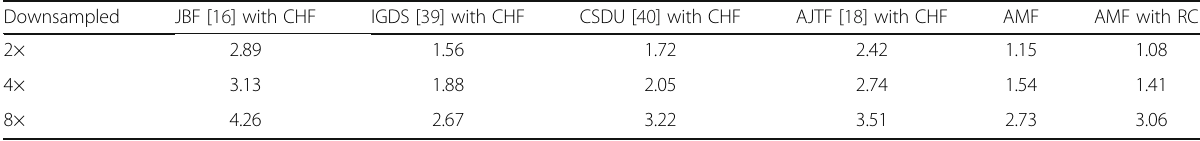
Table 4 RMSE performances achieved by different depth enhancement methods on Middlebury dataset and RGBD dataset Downsampled JBF [16] with CHF